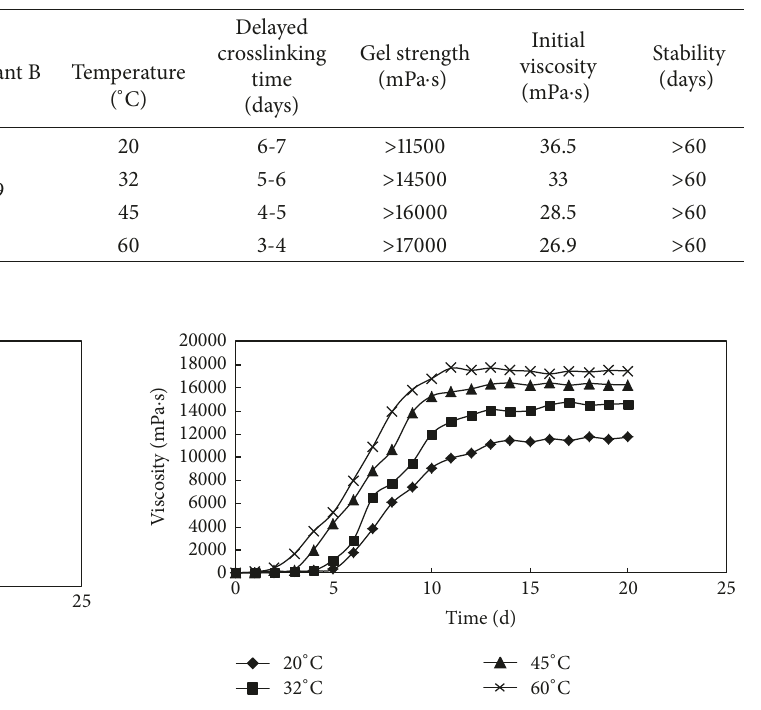
Figure 5: The changing process of viscosity at different tempera-